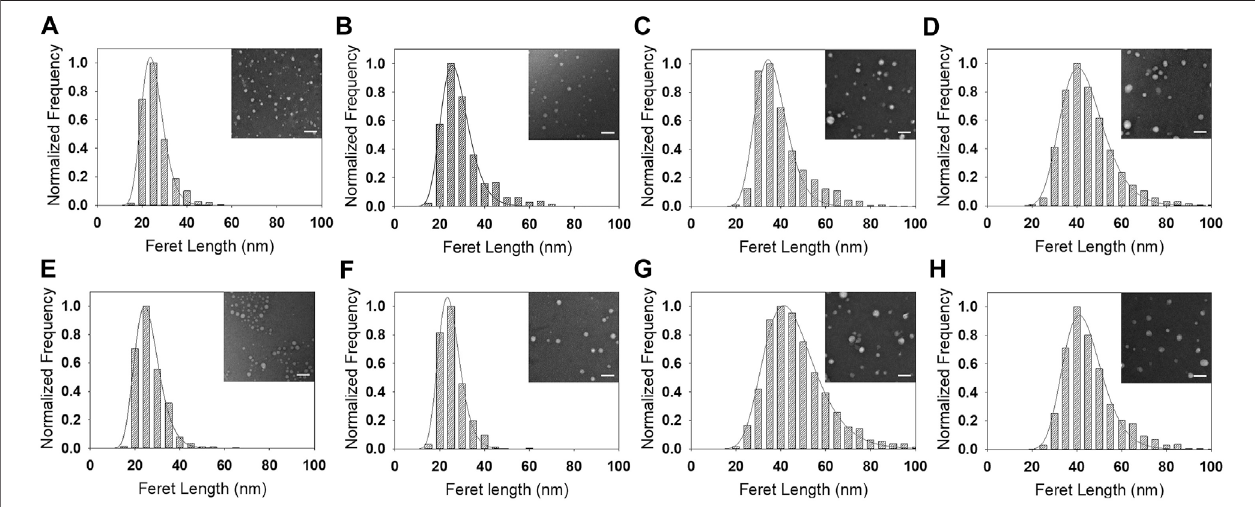
FIGURE3| Sizedistributionsandlognormal fi tsof (A – D) PS- b -PEONPsand (E – H) PCL- b -PEONPssynthesized via EM-NPandencapsulating (A,E) Coumarin6, (B,F) , DEX, (C,G) Lutein, and (D,H) SAHA. Inset: sample TEM image; scale bar: 100 nm. Full size versions of TEM images are available as Supplementary Figure S3